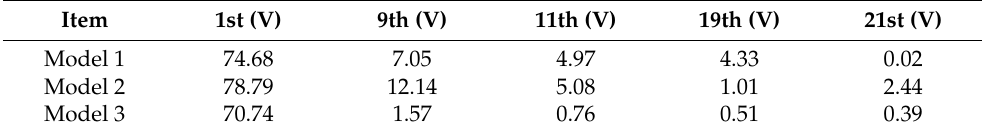
Table 5. The amplitude of Back − EMFs harmonics in the three models.